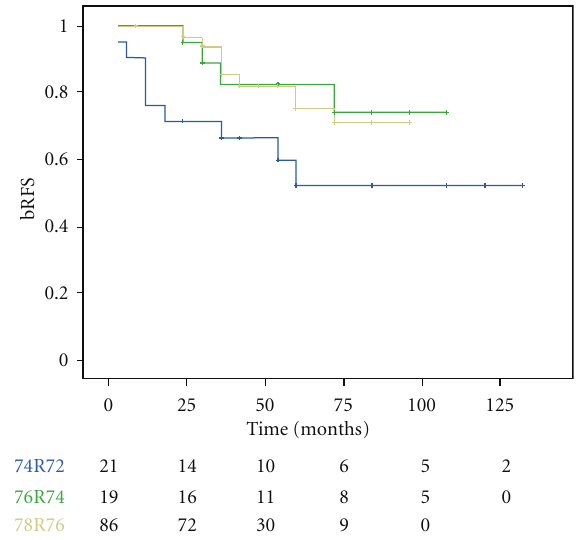
Figure 1: Biochemical relapse-free survival according to prescrip- tion group.